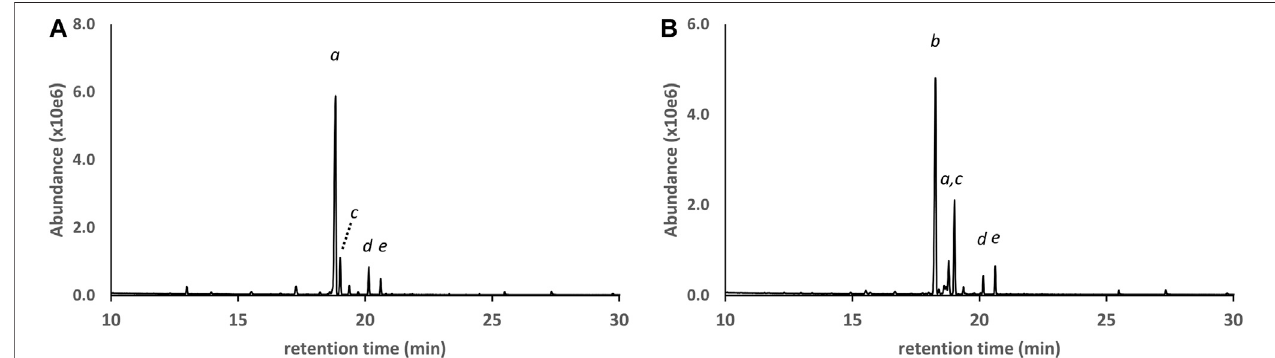
FIGURE 9 | GC-MS chromatograms for two different bulk THC distillates in which the primary cannabinoid was either d9THC (A) or d8THC (B) . Peak labels d9THC( a ); d8THC( b ); d6a,10aTHC(c); 6aR,9R-d10THC( d ); CBN ( e ). Lower levels of additional THC isomers ( not labeled ) were also identi fi ed in both distillates. See text for